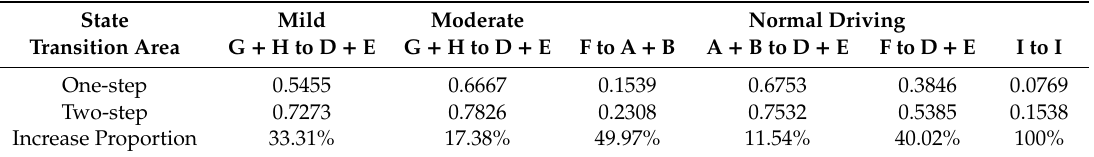
Table 7. Description with significantly increased under di ff erent states.